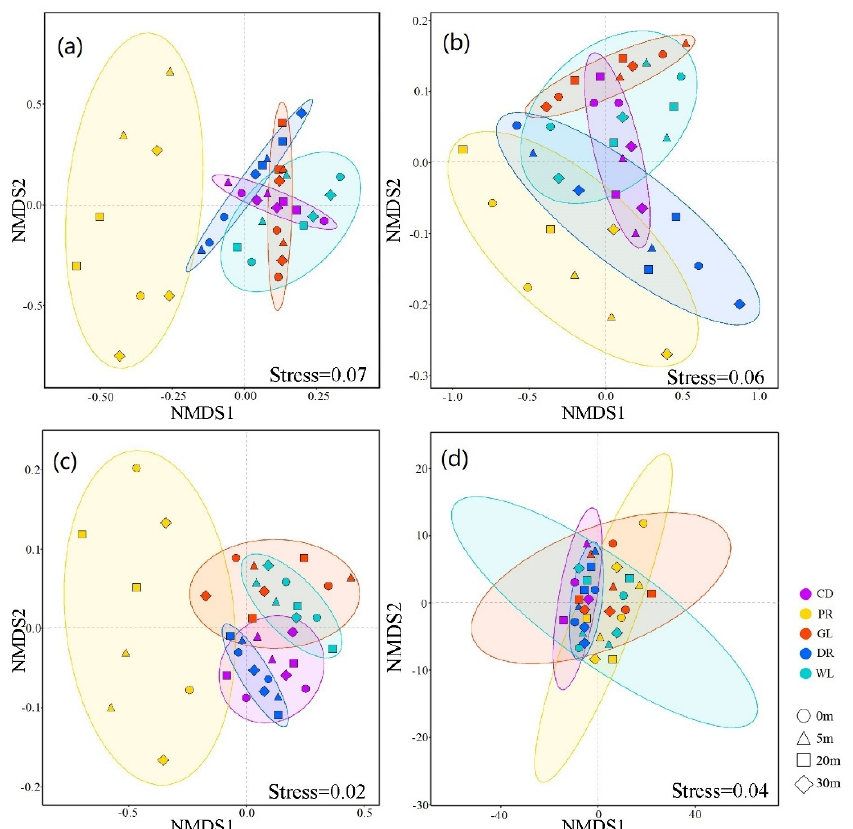
Figure 5. The non-metric multidimensional scaling ordinations (NMDS) of all epigeic arthropods ( a ), natural enemies ( b ), insect herbivores ( c ), and neutrals ( d ). Non-metric multidimensional scaling (NMDS) based on Chord Measure for epigeic arthropods assemblages in different samples ( n = 40 plots, 2 dimensions, Bray–Curtis distance, stress < 0.2). GL, WL, CD, DR, and PR represent grassland, woodland, irrigation canals and ditches, dirt roads, and paved roads.